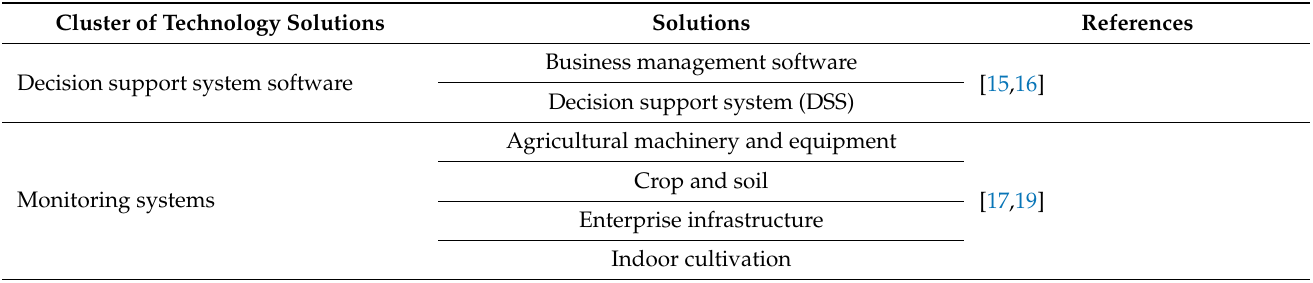
Table 1. List of the Agri 4.0 solutions